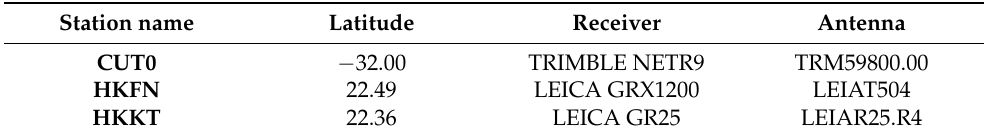
Table 3. The information of the receivers and antennas.